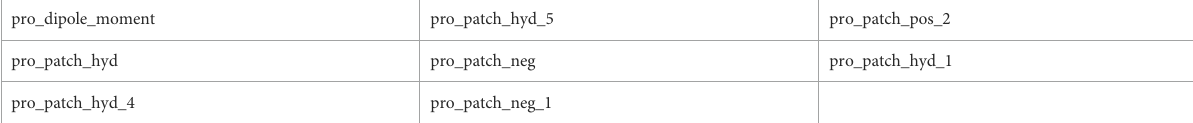
TABLE 5 8 features out of 51 were selected having a feature score of three using the feature scoring table for ADRB2. pro_dipole_moment